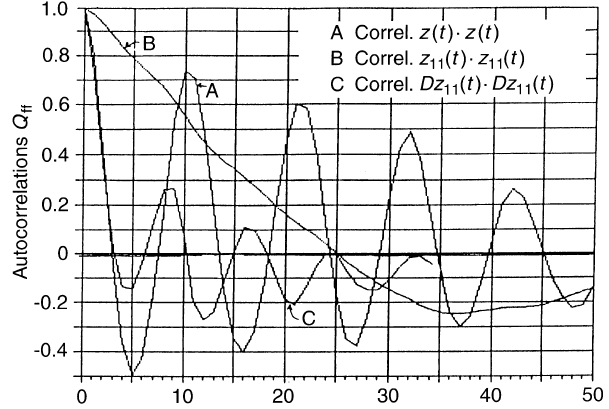
Fig. 7. Component